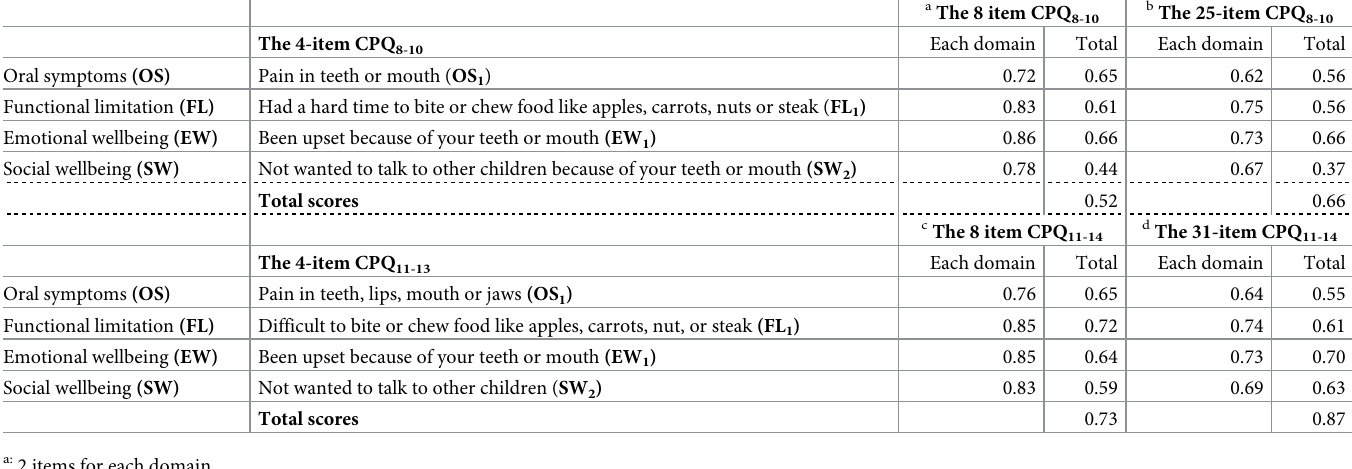
4-item CPQ was acceptable for comparisons at a group level, the reliability of the 4-item 11-14 should be evaluated in future studies. The 4-item CPQ CPQ 8-10